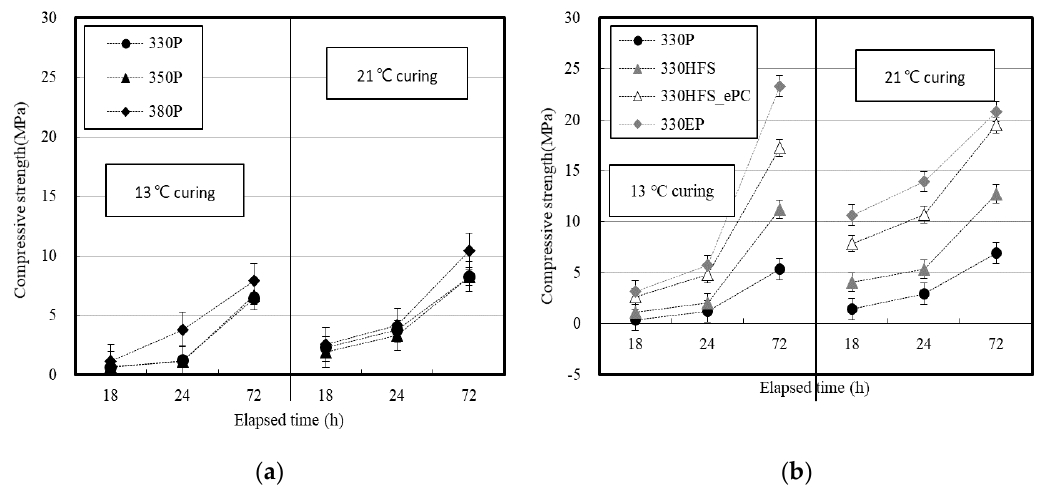
Figure 2. Concrete strength development at early age: ( a ) Cement amount and ( b ) cement type and chemical admixture.